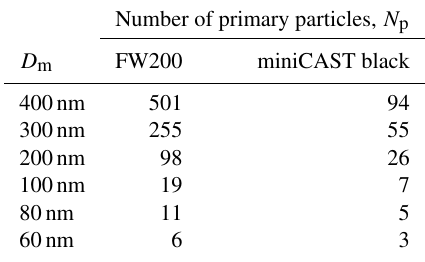
Table E1. Number of primary particles in soot aggregates as a func- tion of soot aggregate mobility diameters D m .